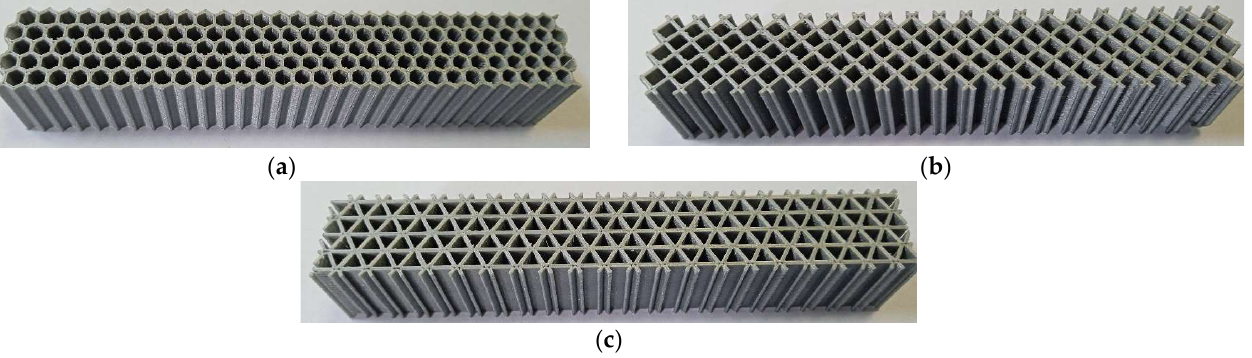
Figure 7. The test specimens: ( a ) hexagonal structure, ( b ) grid structure, ( c ) triangle structure. Two testing phases were completed to investigate the symmetric and asymmetric bending behavior of the structures: